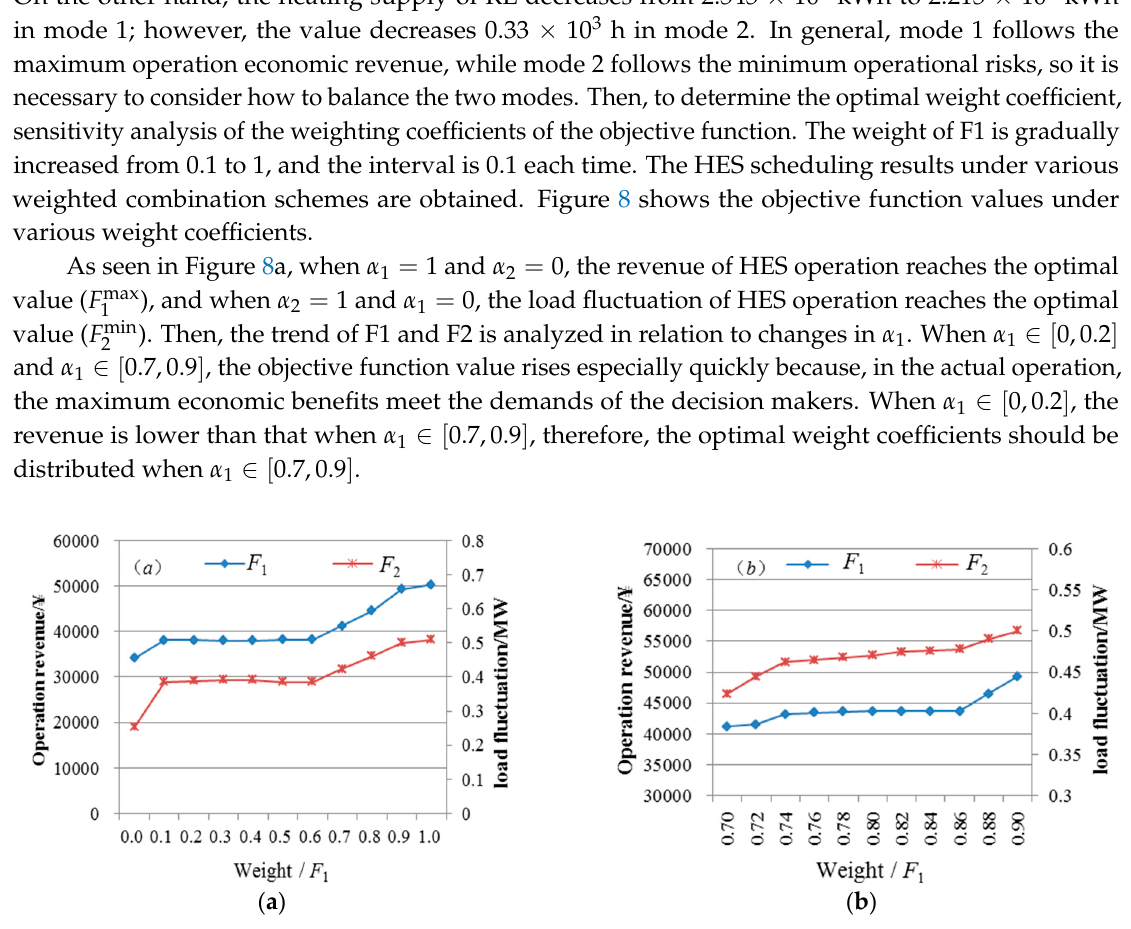
Figure 8. Objective function values under α 1 ∈ [ 0,0.2 ] ( a ) and α 1 ∈ [ 0.7,0.9 ] ( b